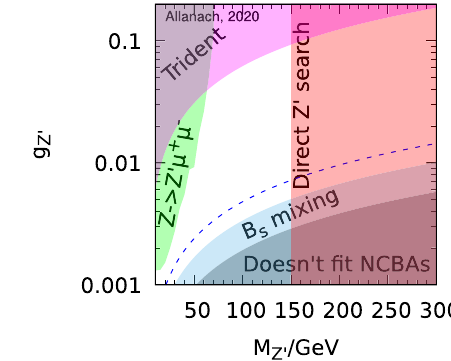
Fig. 9 Constraints upon ( B 3 − L 2 ) eg for M Z (cid:2) ≤ 300 GeV. sin 2 θ sb has been set as in (18) such that every point fits the NCBAs. The white region is currently allowed. The red and blue coloured regions show the 95% excluded regions from a 13 TeV 36 . 1 fb − 1 ATLAS Z (cid:2) → μ + μ − search [77] and from B s − B s mixing as in (20), respectively. The latter bound moves from the blue coloured region at lower C 9 = − 0 . 65 to the region below the dashed line for central C 9 = − 0 . 97. The magenta region shows the region ruled out by the neutrino trident process and the green region by a CMS search in 77 . 3 fb − 1 of 13 TeV pp collisions for Z 0 → μ + μ − Z (cid:2) → 4 μ [72]. In the grey region at the bottom of the plot, the effect of the Z (cid:2) on the NCBAs is too weak to fit